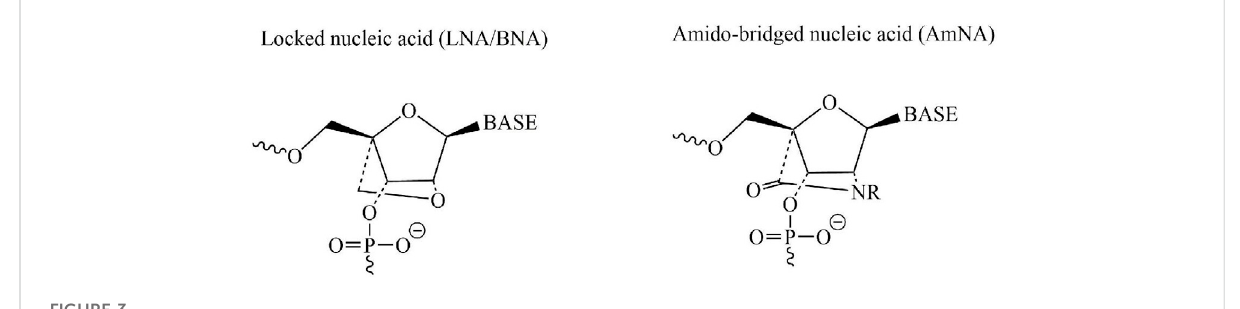
FIGURE 3 Chemical structures of two nucleotide modi fi cation called AmNA and LNA/BNA possessing a potential therapeutic candidate for treatment of